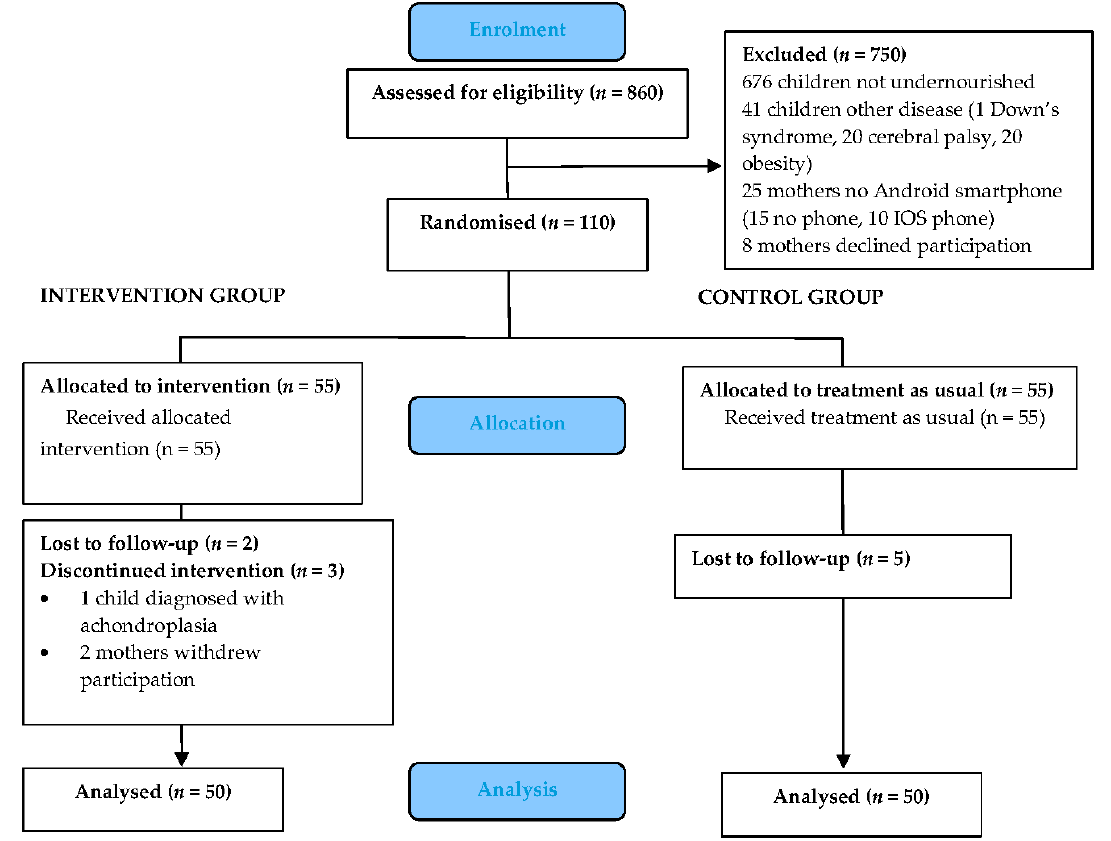
Figure A1. CONSORT diagram describing study enrolment and allocation.